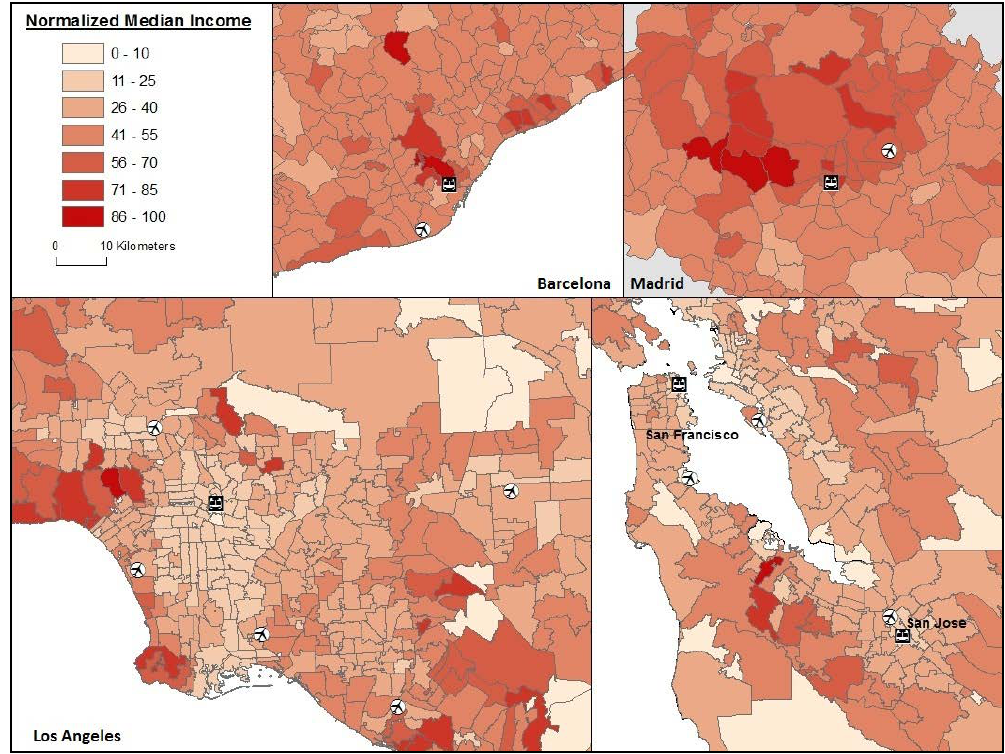
Figure 5 Normalized Median Household Income Comparisons: Barcelona, Madrid, Los Angeles and San Francisco Bay